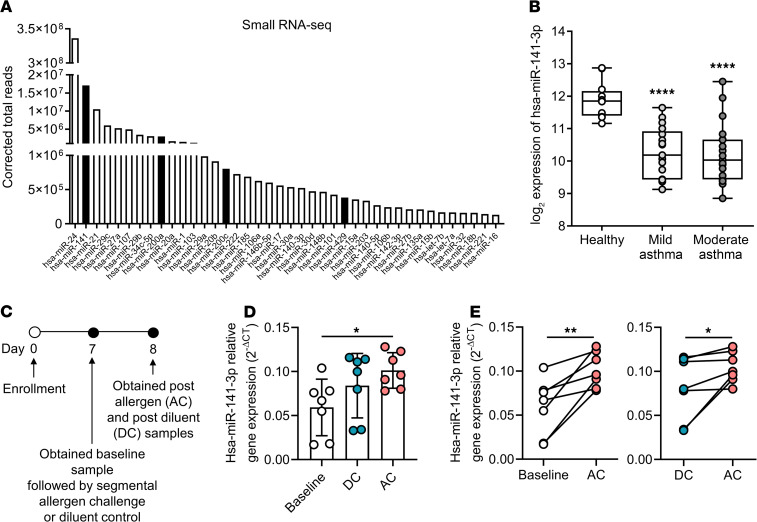
miR-141 is abundantly expressed in the human airway epithelium and induced upon airway allergen challenge in asthma.(A) Forty most highly expressed miRNAs by small RNA sequencing analysis of bronchial epithelial brushings (n = 16). miR-141/200 family miRNAs (141/200a/200c/429) are highlighted by black bars. (B) Microarray analysis of hsa-miR-141-3p in human epithelial brushings from mild asthmatics (not using inhaled corticosteroids) and moderate asthmatics (using inhaled corticosteroids) compared with healthy controls (n = 12–16/group, 1-way ANOVA with Dunnett’s multiple comparison test, ****P < 0.0001). (C) Timeline of segmental airway allergen challenge of allergic asthmatic subjects for collection of bronchial brushings. (D and E) Expression level of hsa-miR-141-3p by TaqMan qPCR in bronchial brushings collected at baseline and 1 day following allergen challenge (AC) or diluent control (DC) demonstrated by group (D) and paired analysis (E) (n = 7/group, 1-way ANOVA followed by Dunnett’s multiple comparison test, *P < 0.05, in D; 2-tailed paired t test; *P < 0.05, **P < 0.01 in E).